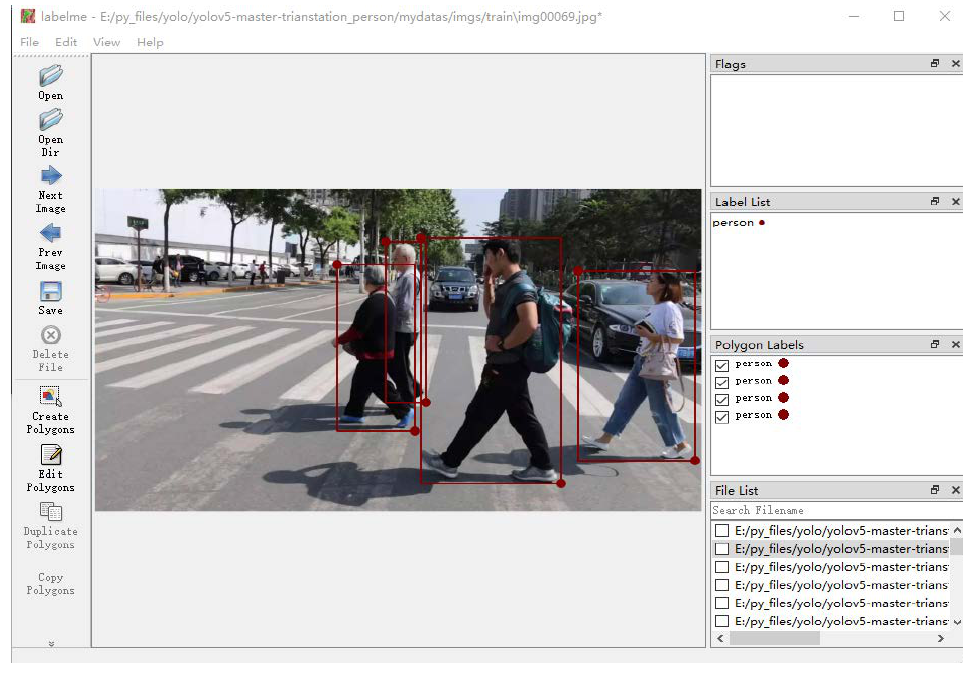
Figure 13. Labelme annotation tool.